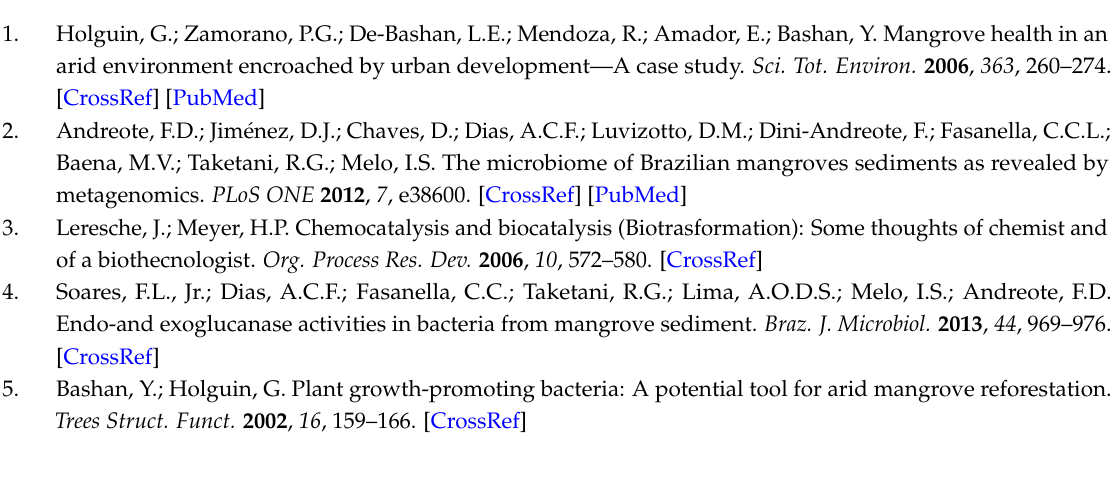
Figure S1: Cultivation plate containing the clone able to degrade carboxymethyl-cellulose (CMC); Figure S2: Annotation of open reading frames (ORF) belonging to the largest mapped contig (22,143 bp) Arrows in colors show the orientation (right/left) indicating the reading position of each ORF The β - N -acetyl-hexosaminidase enzyme is shown in red, with 1065 bp and match with BglX ( β -glicosidases) and affiliated with family GH3 of glycoside hydrolases Numbers 1 to 1065 represent the size of the fragment in base pairs; Figure S3: SDS-PAGE after elutions of the purified protein, in kDa M: Molecular marker; pET28a: Plasmidial vector; pellet: Pellet with fase separation; sup: supernatant after centrifugation (fases separation); flow: lise buffer (pH 8.0); c1 and c2: washing buffer (pH 6.3); d1 and d4: elution buffer 1 (pH 5.9); e1 and e4: elution buffer 2 (pH 4.5); Figure